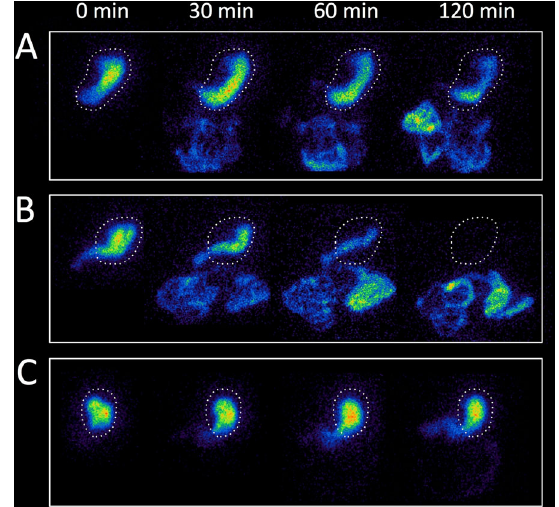
Fig. 3 Gastric emptying scintigraphy images at 0, 30, 60, and 120 min after radioactive meal ingestion. a Healthy control with normal gastric emptying time ( T 1/2 72 min). The dashed line designates the stomach. b PD patient with rapid gastric emptying time ( T 1/2 26 min). c Vagotomized patient with severely increased gastric emptying time ( T 1/2 > 180